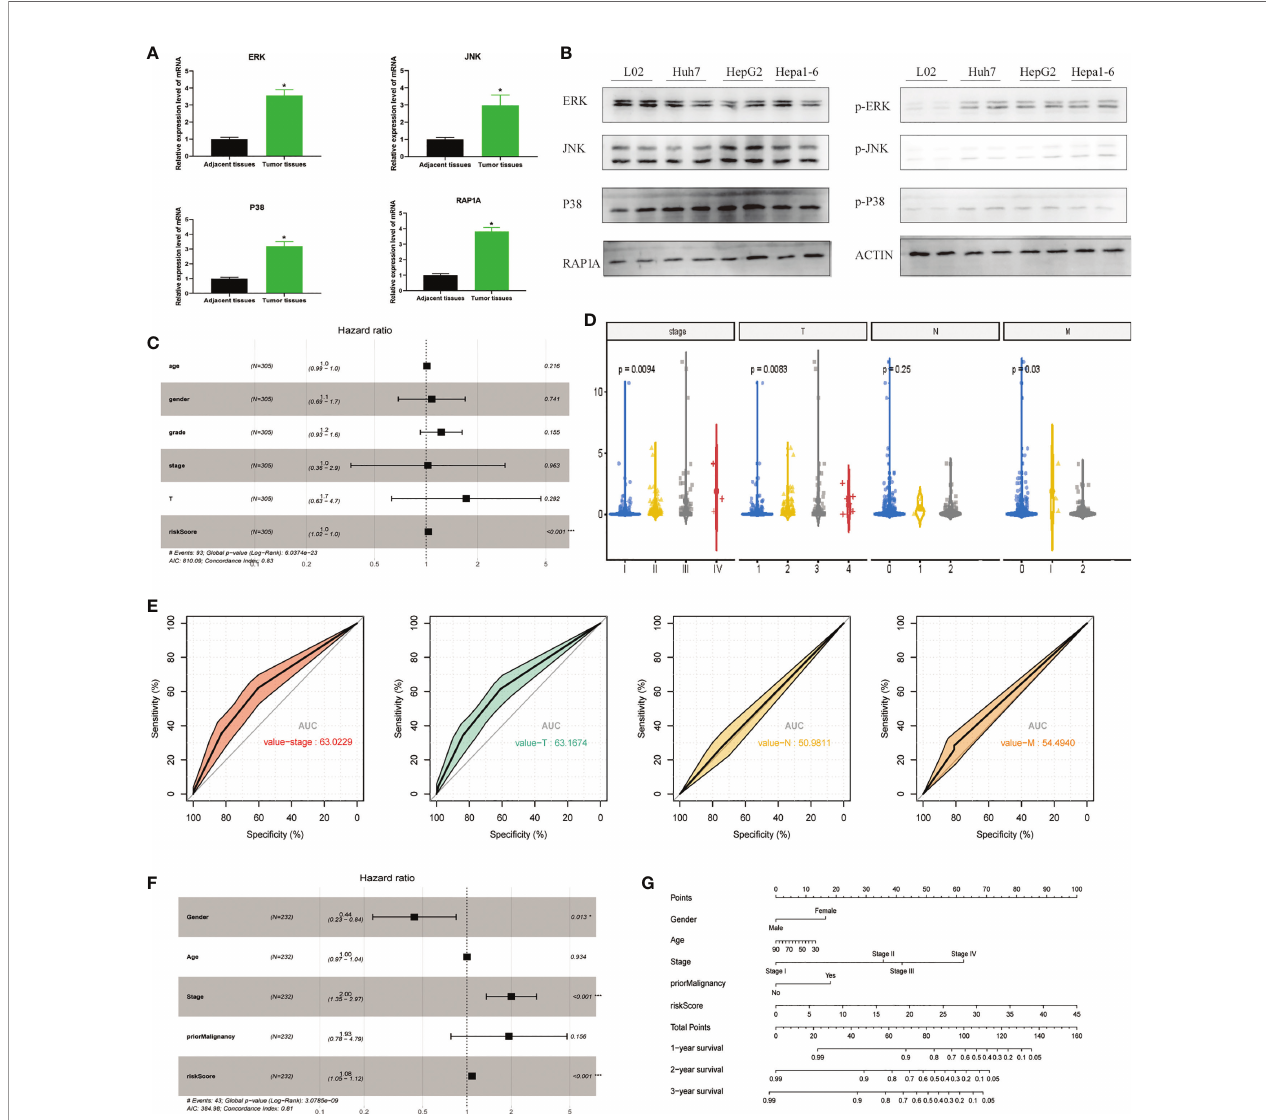
FIGURE 1 | Establishment of the risk signature with MAPK-RAP1A related genes in the training (TCGA) and validation database (ICGC). (A) RT-qPCR was used to detect the expression of ERK, JNK, p38, RAP1A in 20 cases HCC tumor tissues and adjacent tissues. (B) Western blot was used to detect the expression of ERK, JNK, p38, RAP1A in Huh7, HepG2, Hepa1-6, and L02 cell lines. (C) Multivariate Cox regression analysis to validate prognosis related clinicopathological characters. (D) The correlation of our MAPK-RAP1A risk signature with the clinicopathological characters (TNM stage) of HCC from the training set. (E) ROC curves of AUC evaluated the ef fi ciency of the risk signature for predicting TNM stage in training set. (F) Multivariate Cox regression analysis to validate prognosis related clinicopathological characters. (G) Nomogram for predicting 1-, 3-, and 5-year OS of LIHC patients in the ICGC cohort. * p < 0.05; *** p <